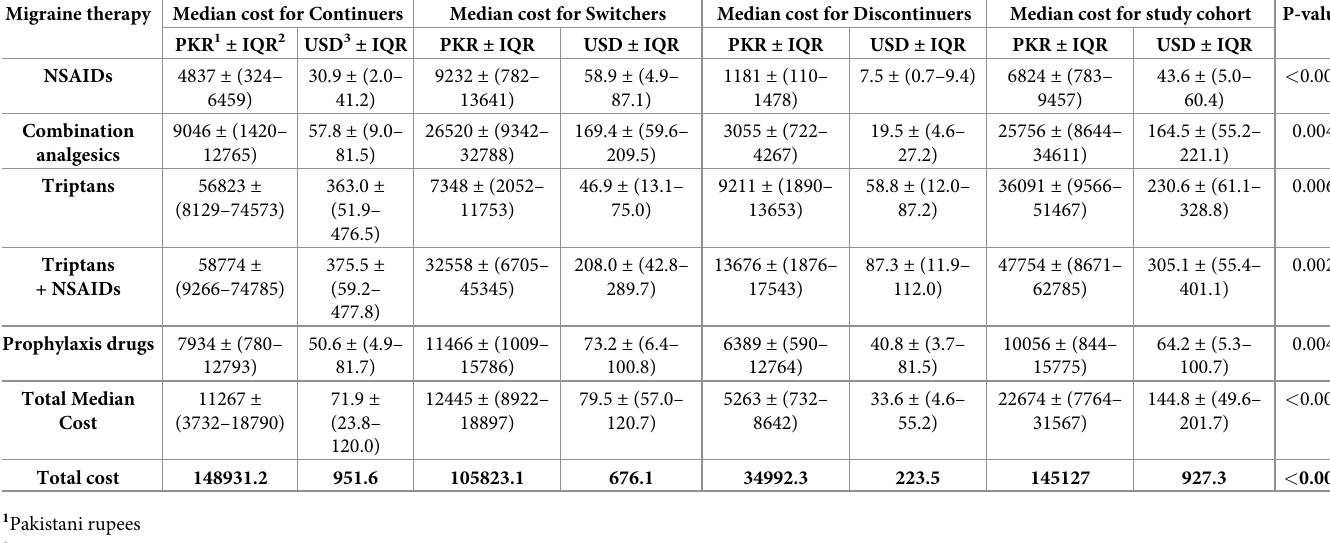
Table 5. Annual treatment cost of each migraine patient with respect to a different class of anti-migraine drugs. Migraine therapy Median cost for